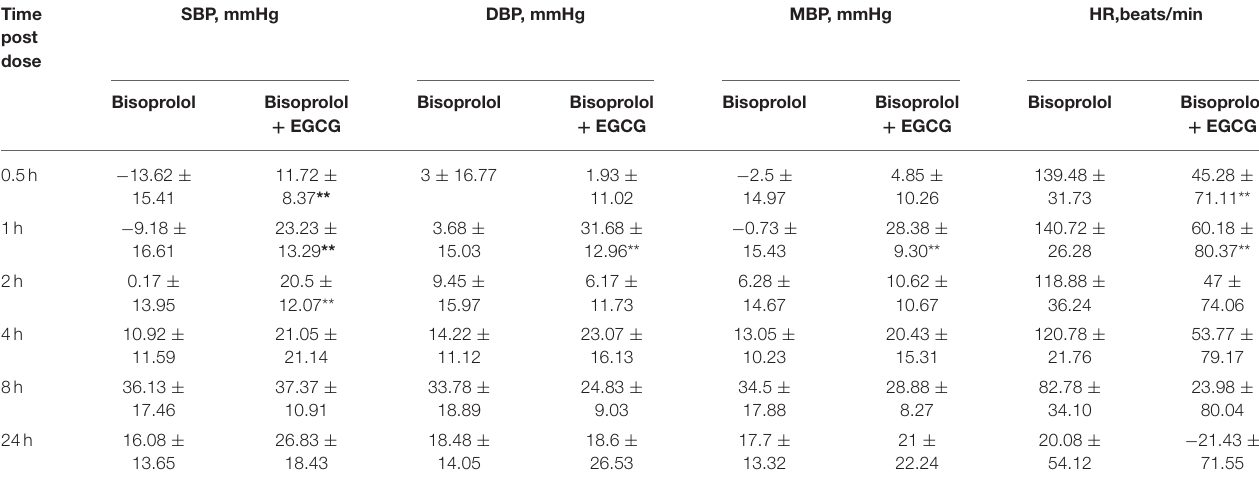
TABLE 7 | The reduction of blood pressure and heart rate after treatment in the two groups in SHRs. Time post